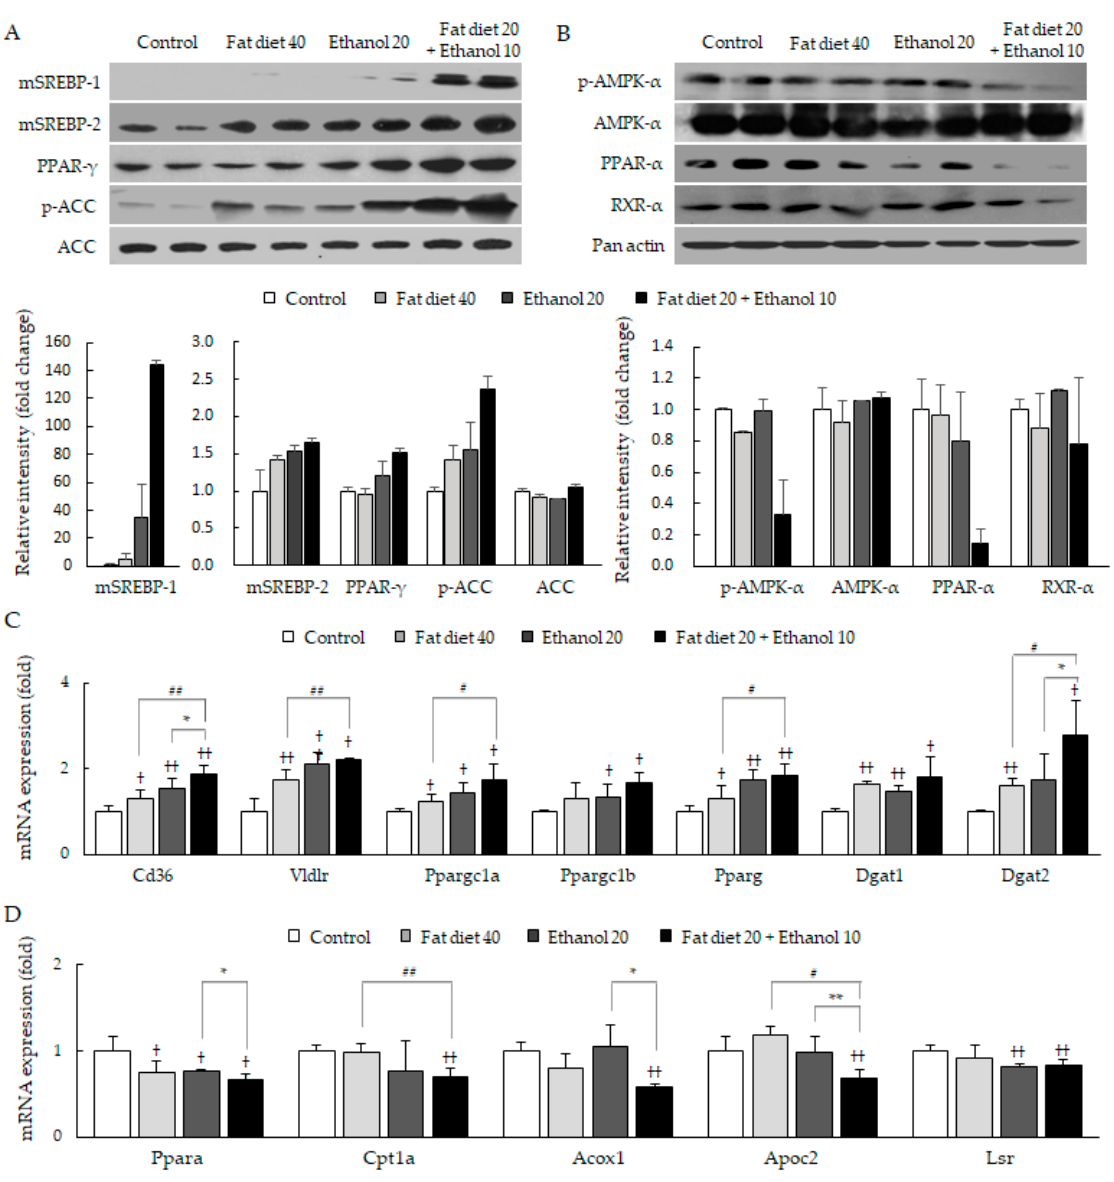
Figure 5. Impairments in lipid homeostasis in hepatic tissues. Western blot and relative intensity analysis for core molecules of lipogenesis ( A ) and lipolysis ( B ), and mRNA expression analyses for core genes of lipogenesis ( C ) and lipolysis ( D ) in hepatic tissues are presented. Data are expressed as the mean ± SD ( n = 6). † p < 0.05 and †† p < 0.01 compared with the control group; # p < 0.05 and ## p < 0.01 compared with the fat diet 40 group; * p < 0.05 and ** p < 0.01 compared with the ethanol 20 group.